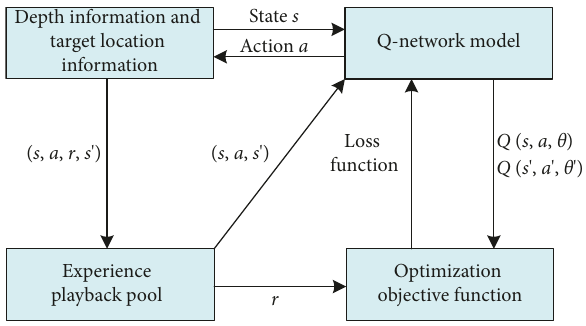
Figure 4: Improved DQN method